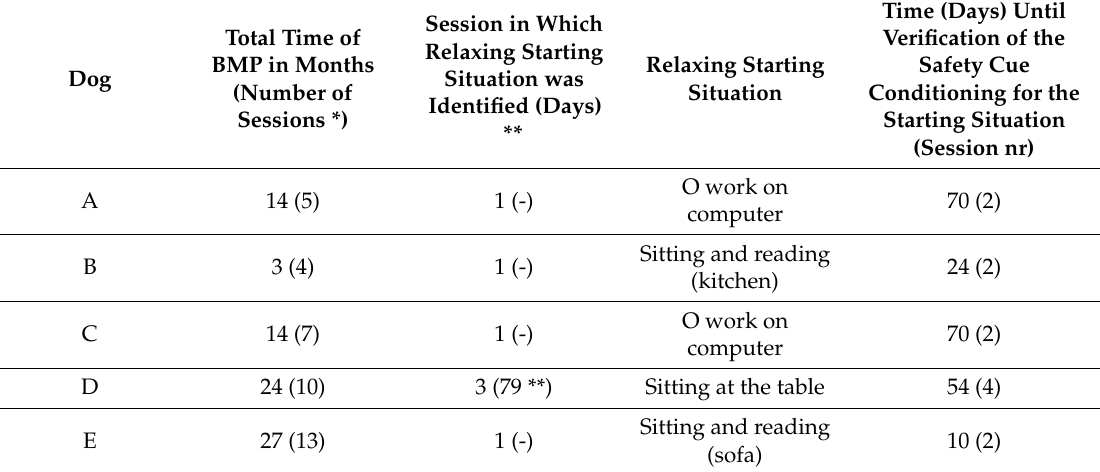
Table 2. Timing of BMP (number of sessions and duration) for di ff erent acspects, as well as identification of the starting situation. * including the first session which involved also the behaviour assessment (duration 120 min, following sessions 45 min). ** days between the first session and the mentioned session. “O” =